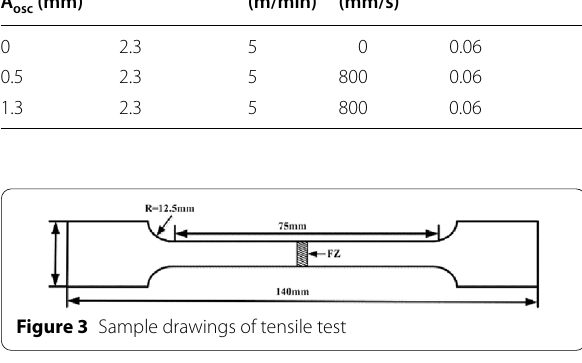
), b top surface for A osc = 0 , f cross section for A osc = 0.5 =